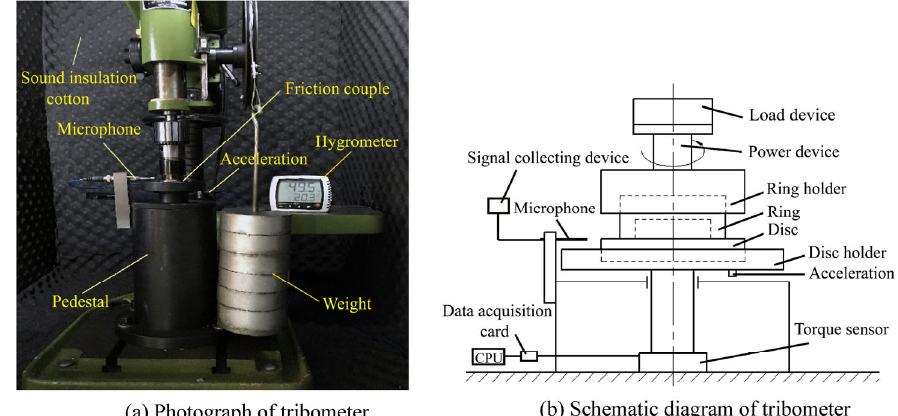
Fig. 1 Experimental apparatus.